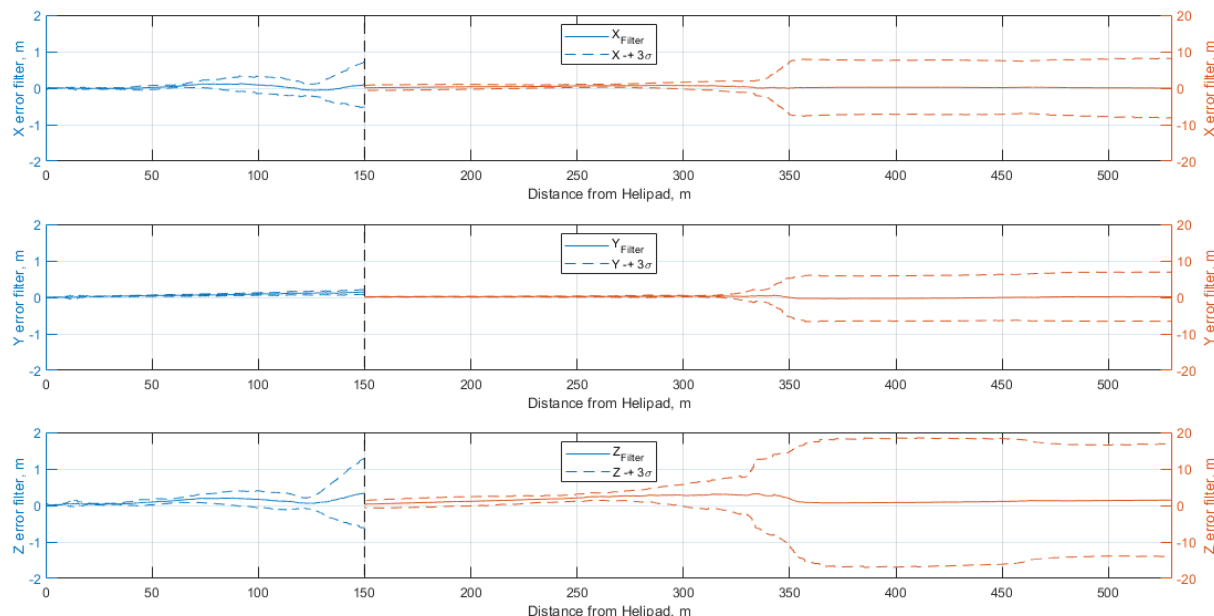
Figure 11. EKF position estimates errors average over 50 simulations and 3 − sigma bounds. VTCA landing trajectory in nominal visibility conditions. The plot scale is increased in the last 150 m to better show the errors in the final phase of the approach.